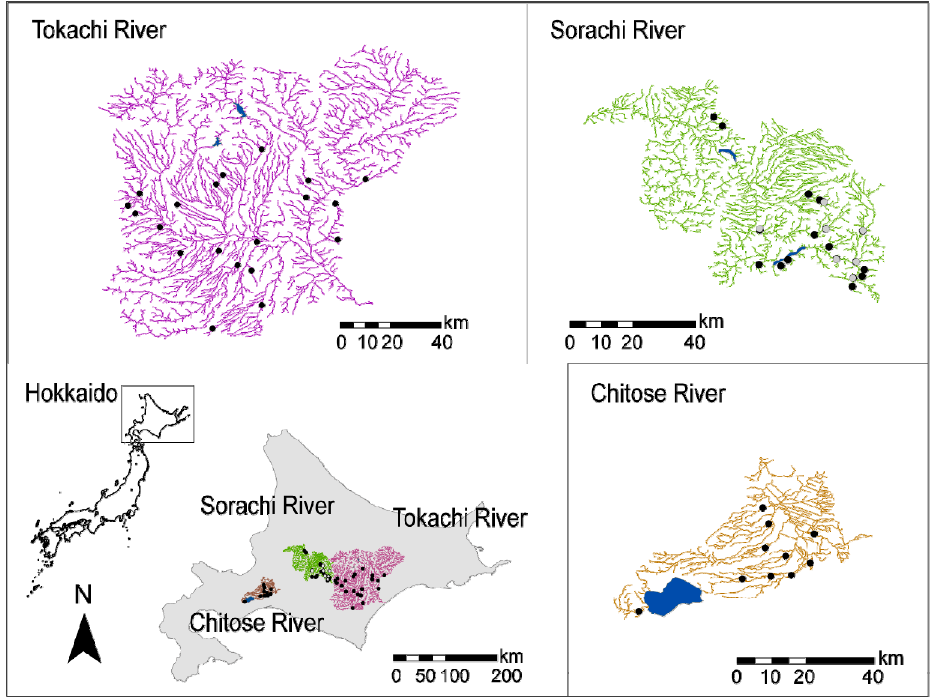
Figure 1. The locations of the study sites in the three studied catchments. In the Tokachi and Chitose river catchments, the black circles indicate the occurrence survey sites. In the Sorachi river catchment, the gray and black circles indicate the sites for only the abundance survey and both the abundance and occurrence surveys, respectively.